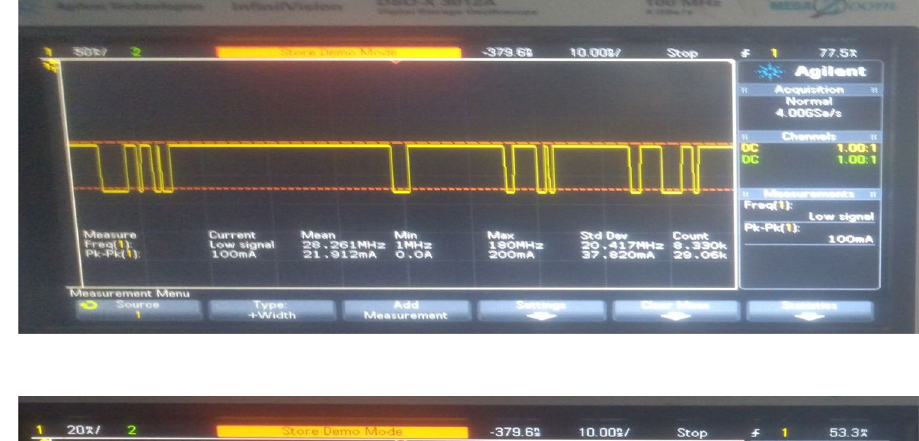
Fig. 16 TRNG output wave- form of FAT-1 design